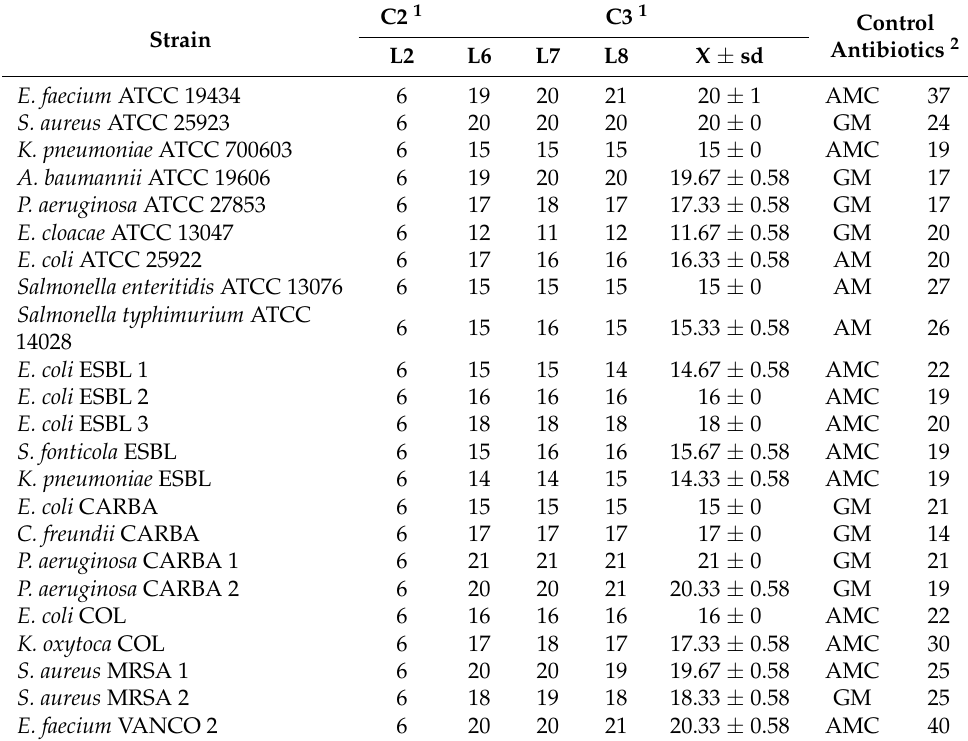
Table 1. Inhibition halos of the products C2 (without silver), C3 (with silver) and control antibiotics (diameter in